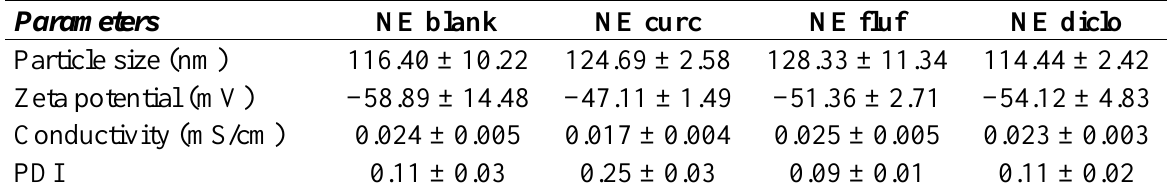
Table 3. Physicochemical properties of blank and drug-loaded nanoemulsions (NE) after 16 cycles of high-pressure homogenization. Measurements were performed in triplicate on a Zetasizer Nano ZS (Malvern, UK) at 25 °C. Samples were diluted with distilled water (1:100 v/v) containing sodium chloride (0.01 mmol) before the experiments to ensure constant conductivity below 0.05 ms/cm. Parameters shown are mean particle size (MPS), zeta potential (ZP), conductivity (cond) and polydispersity index (PDI). Values represent the mean of at least three formulations (n ≥ 3) and are given ±